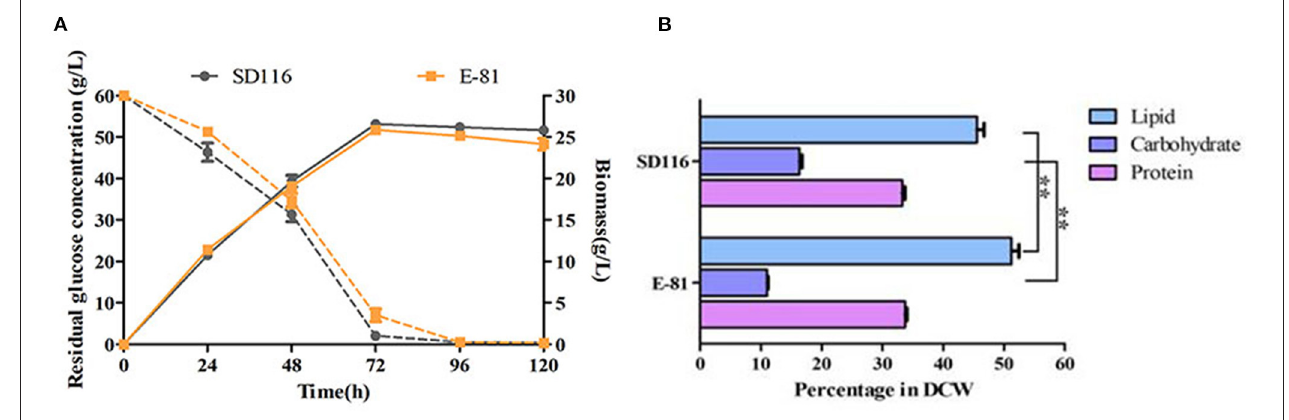
FIGURE 3 | Characterization of cell growth (A) and biomass composition (B) in strains SD116 and E-81. ** P <